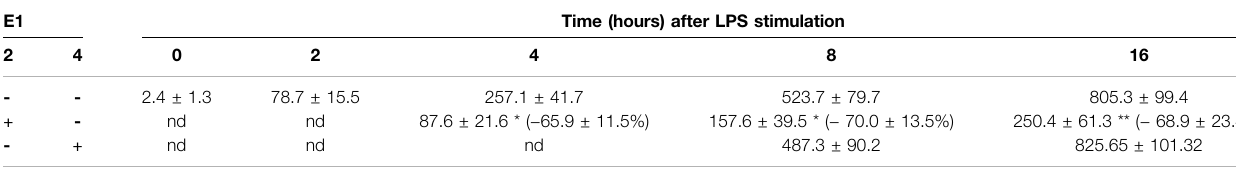
E1 at the concentration of 100 μ g/ml was added to cells 2 or 4 h after LPS stimulation ( fi rst and second column). Supernatant were collected at the indicated periods of time after LPS stimulation and analyzed for IL-1 β release. Numbers in brackets denote the percentage change of IL-1 β release compared to the corresponding treatment with LPS. Data are means ± SEM of three independent experiments. * p < 0.05 and ** p < 0.01 versus the corresponding LPS stimulation. Student ’ s t test. nd, not determined.